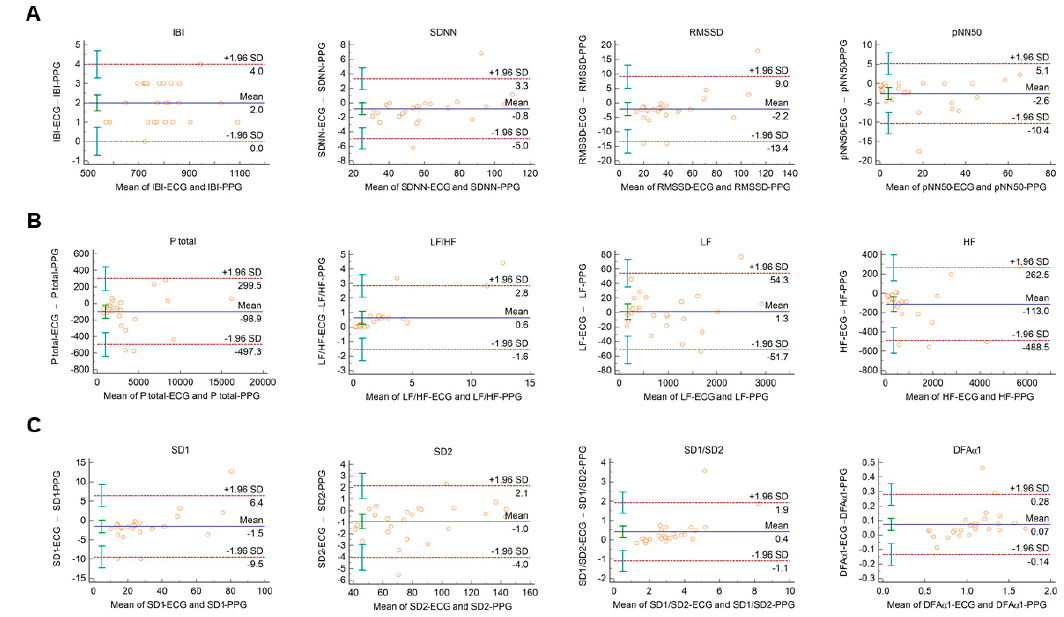
Figure 2. Bland–Altman plots of HRV/PRV parameters computed by the Kubios Premium algorithm from 2-min long ECG (indicated as ‘parameter name-ECG’) and PPG (indicated as ‘parameter name-PPG’) recordings obtained during cold pressor test. ( A ) Time-domain parameters: IBI (interbeat interval), SDNN (the standard deviation of IBIs), RMSSD (the square root of the mean squared differences of successive IBIs), pNN50 (the proportion of differences of successive IBIs exceeding 50 ms). ( B ) Frequency-domain parameters: Ptotal (total spectral power), LF/HF (ratio of low frequency to high frequency), LF (absolute power of the low-frequency band (0.04–0.15 Hz)), HF (absolute power of the high-frequency band (0.15–0.4 Hz)). ( C ) Non-linear parameters: SD1 (Poincaré plot standard deviation perpendicular to the line of identity), SD2 (Poincaré plot standard deviation along the line of identity), SD1/SD2 (ratio of SD1-to-SD2), DFA α 1 (short-term fluctuation slope obtained by detrended fluctuation analysis). Bias is calculated as the mean of differences (indicated as ‘Mean’—blue solid line) and is presented with 95% confidence intervals (green) and +/ − 1.96 standard deviations (SD) and their confidence intervals.